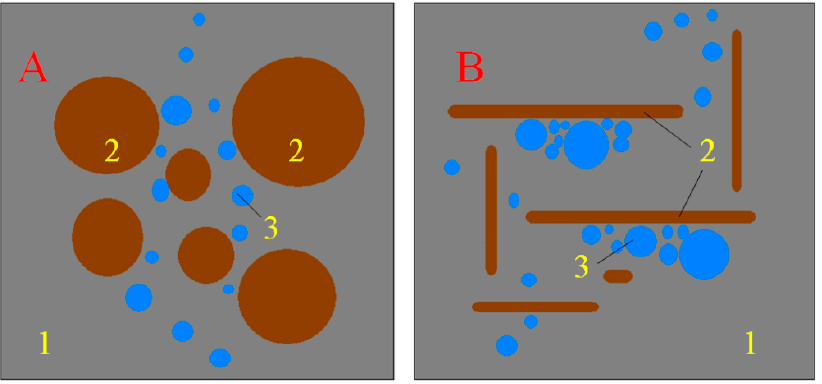
Figure 7. Scheme of air retention in a concrete mix during vibration. ( A ) Mixture with aggregate shaped, ( B ) mixture with flat aggregate. Markings in the drawing: 1—cement paste, 2—aggregate grains, 3—air bubbles moving upwards during vibration.